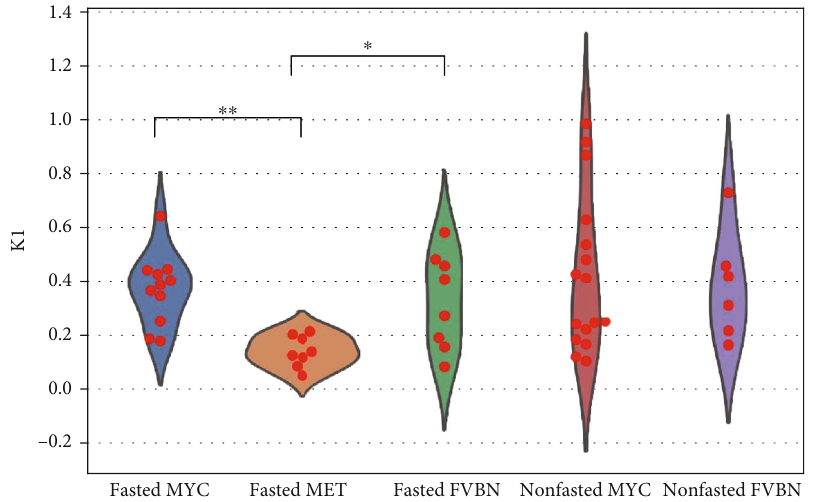
n = 11 and n = 16 tumors,